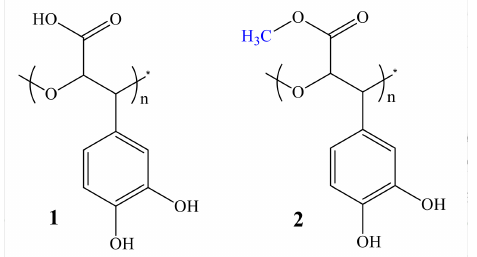
Figure 2. Poly[3-(3,4-dihydroxyphenyl)glyceric acid] (PDHPGA) ( 1 ) and poly[2-methoxycarbonyl-3- (3,4-dihydroxyphenyl)oxirane] (PMDHPO) ( 2